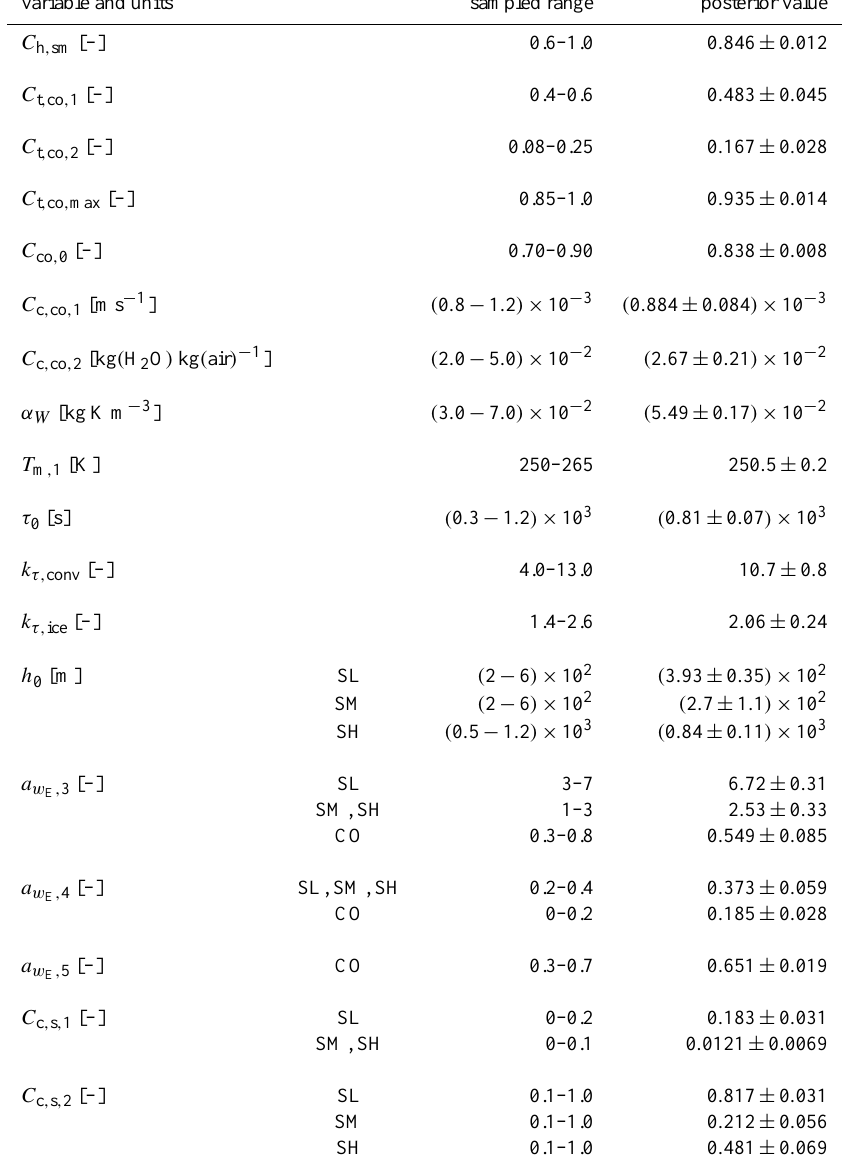
Table 3. List of the perturbed parameters of the scheme together with their priory ranges. Long dash in the first column indicates that the corresponding variable is non-dimensional. The symbols “SL”, “SM”, “SH”, and “CO” indicate particular cloud types according to classification used in the scheme. In the last column, Bayesian mean and standard deviation are